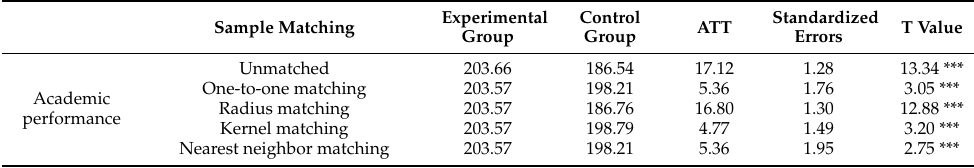
Table 6. ATT of extracurricular tuition in different matching methods.